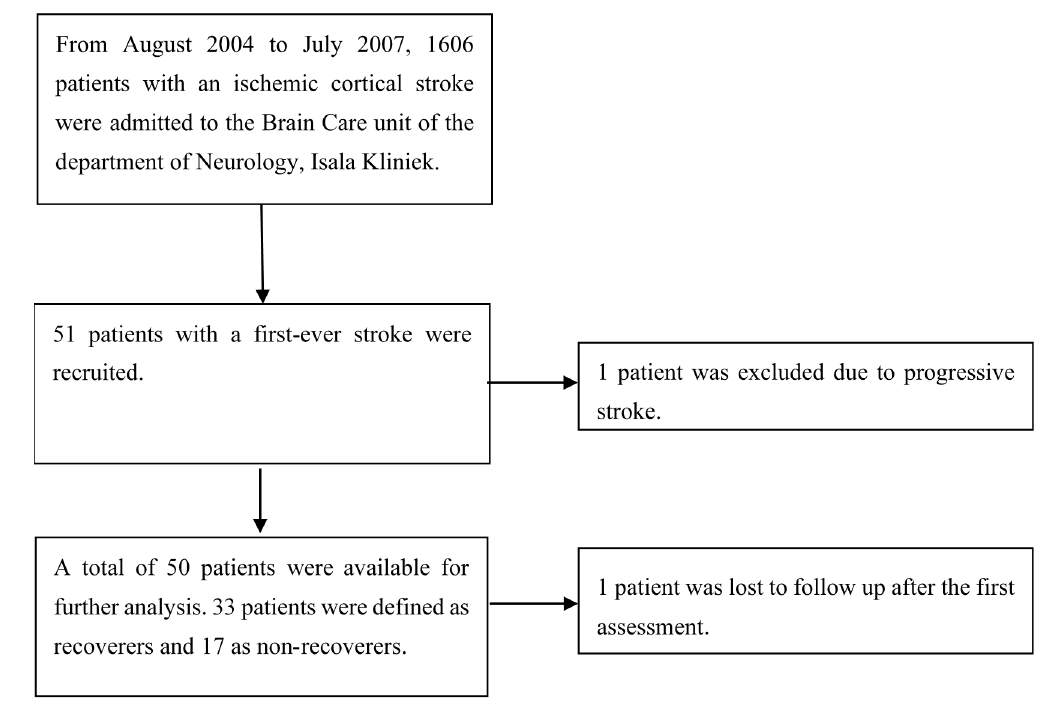
Figure 1. Patient exclusion flowchart. Table 1. Patient characteristics of the total group ( N = 50, second column), and subgroups (right-hand columns) in relation to spontaneous neurological upper limb motor recovery early after